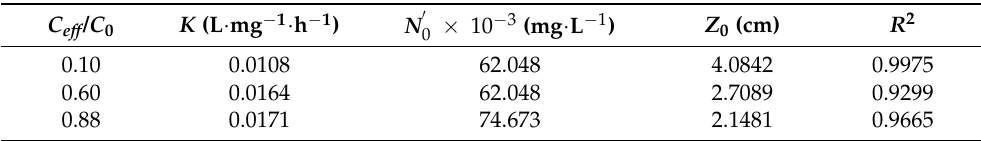
Figure 11. Lines of bed depth service time for 0.10, 0.60, and 0.88 breakthrough for diverse bed heights (Co given as 1000 mg/L; Q given as 10 mL/min). Table 5. Service time model parameters for bed depth used for phenol adsorption ( C 0 given as 1000 mg/L; Q given as 10